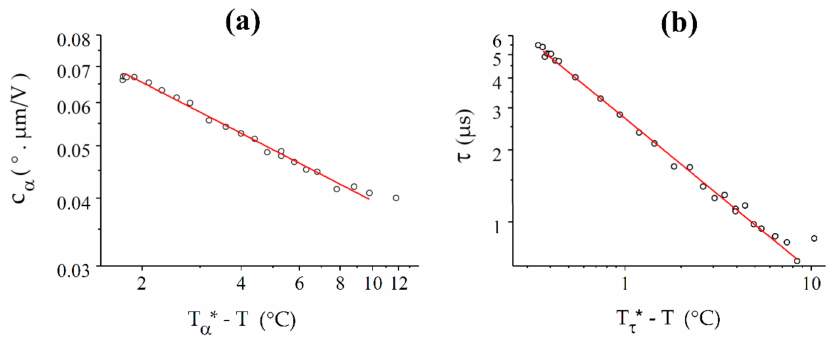
Figure 12. Best fits (solid red lines) of c α ( T ) and τ ( T ) with power laws for CB6OCB: ( a ) For c α ( T ) , the fit c α ( T ) ∝ ( T α * − T ) − β α provides T α * = 109.78 ◦ C and β α = 0.31; ( b ) The power law for the response